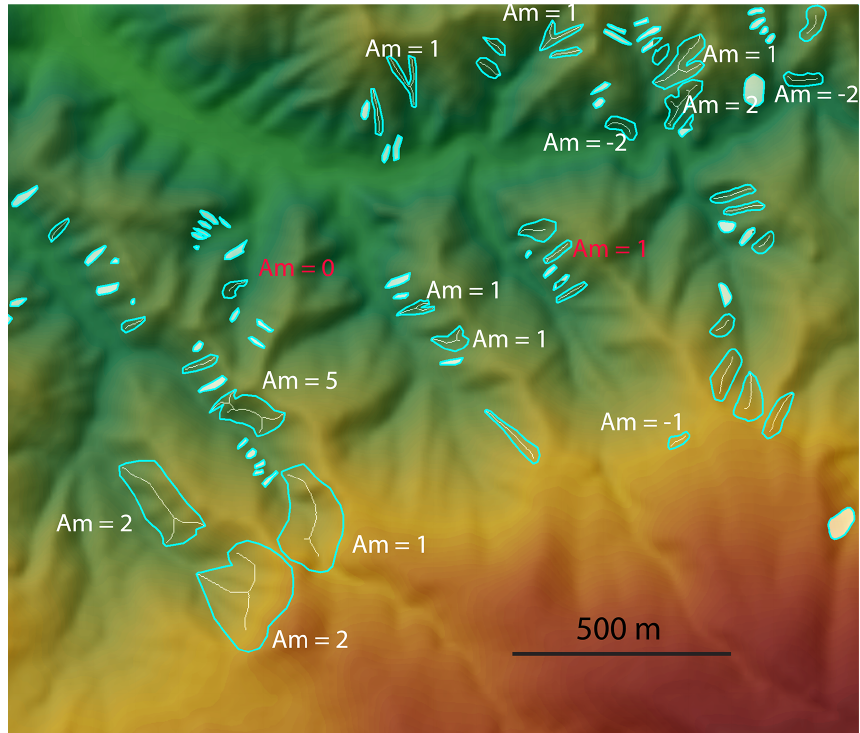
Figure 5. Part of the Northridge landslide polygon inventory overlaid on a hillshaded DEM. The skeleton raster output is shown for all polygons larger than 1000m 2 and with K> = 2 (35 polygons). Polygons with K < 2 are filled in white and considered clean. White labels show erroneous polygons detected by the algorithm, with positive numbers giving the number of secondary branches detected, − 2 meaning ridge or river crossing and − 1 indicating a slope smaller than 12 ◦ . Red labels show incorrectly diagnosed or dubious results within this sample. Polygons with skeleton but no labels have been correctly classified as